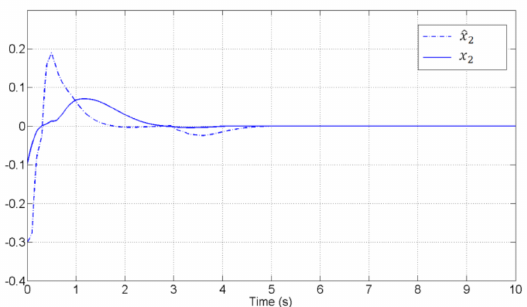
Figure 2. State trajectory of x 1 and state estimation trajectory ˆ x 1 .